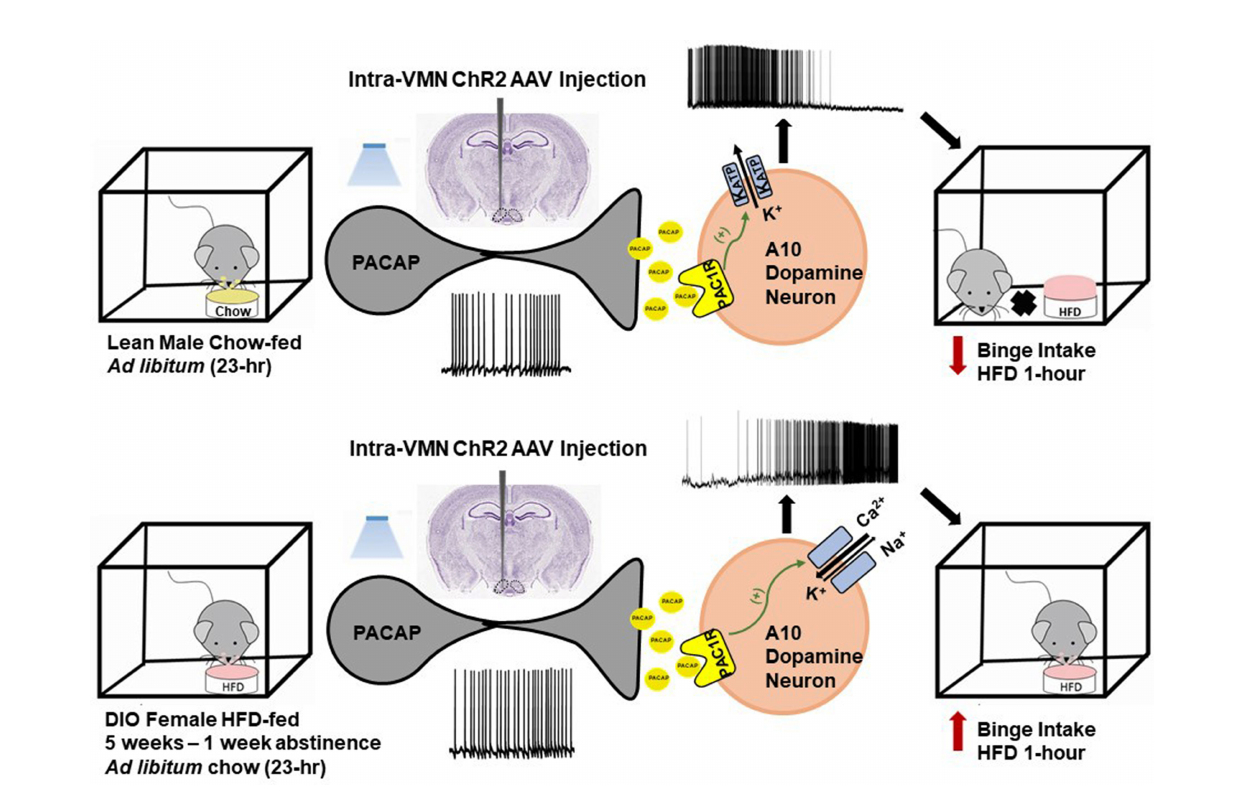
FIGURE 6 | Schematic representation of the energy status-dependent changes in PAC1 receptor/effector coupling at VMN PACAP/VTA A 10 DA synapses. Top row , In VMN PACAP neurons from lean chow-fed males, optogenetic stimulation leads to activation of PAC1 receptors that couple to K ATP channels in A 10 DA neurons; causing hyperpolarization cessation of fi ring. This in turn attenuates binge feeding brought on by brief intermittent exposure to HFD. Bottom row , In VMN PACAP neurons from DIO females, optogenetic stimulation leads to a far more heterogeneous response; with the majority of A 10 DA neurons being excited via activation of mixed cation channels that ultimately potentiates binge feeding